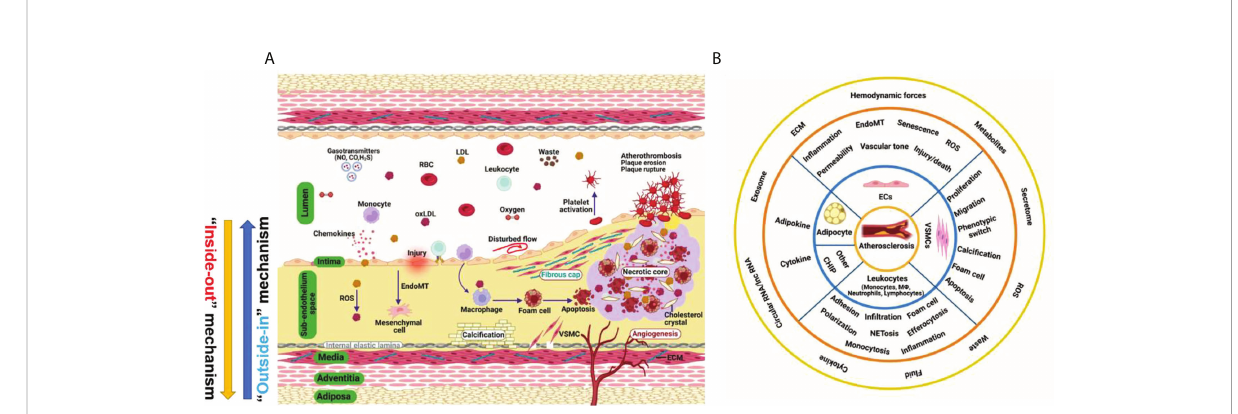
FIGURE 1 Hallmark of atherosclerosis. (A) The pathogenesis of atherosclerosis. Vascular components of atherosclerotic artery which include tunica adiposa, tunica adventitia, tunica media, sub-endothelium space and tunica intima. For simplicity, external elastic lamina in the blood vessel was not depicted. The interplay of different vascular cell types within the local vascular niche drives atherosclerosis development. Both “ inside-out ” and “ outside-in ” mechanism contribute to the development of atherosclerosis. (B) A holistic overview of hallmarks of atherosclerosis and crosstalk among vascular cell components. Atherosclerosis is complex disease involving different cell types at different vascular layers. The hallmark events in different cell types act in concert to promote atheroprogression. CHIP, clonal hematopoiesis of indeterminate potential; ECs, endothelial cells; ECM, extracellular matrix; EndoMT, endothelial-mesenchymal transition; ROS, reactive oxygen species; VSMC, vascular smooth muscle